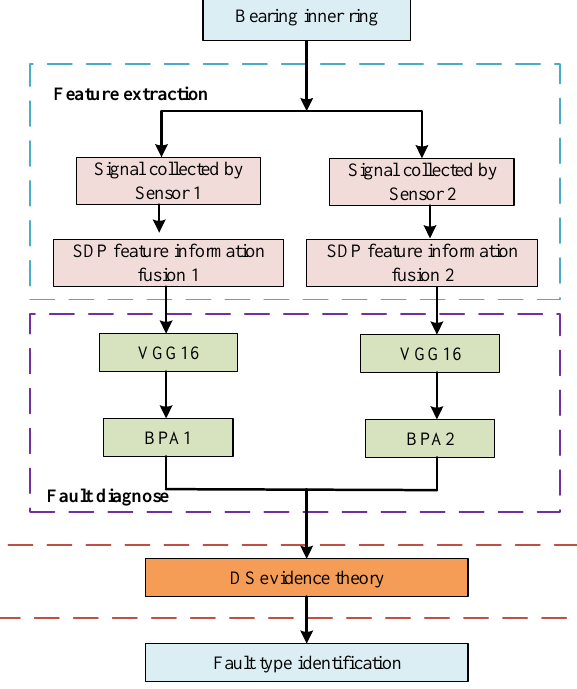
Figure 6. DS evidence theory technical route.